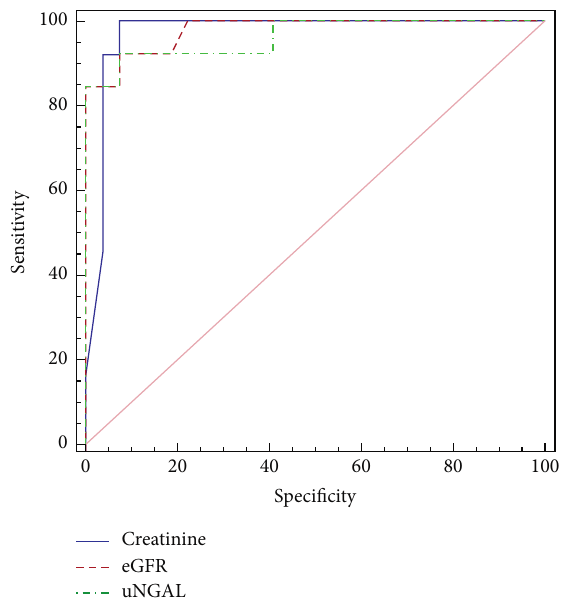
Figure 2: Graph ROC curves showing area under the curve of three-month follow-up UNGAL and conventional biomarkers to predict renal response to induction. It showed an AUC value of 0.966, with slight differences compared to other conventional